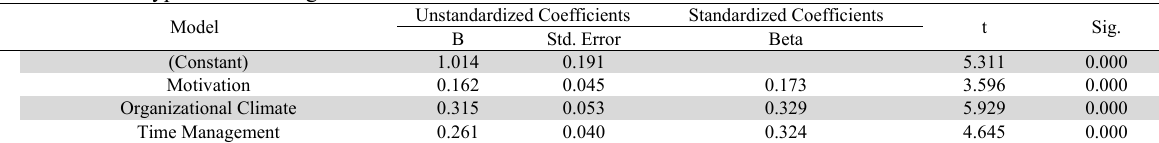
The Results of Hypothesis